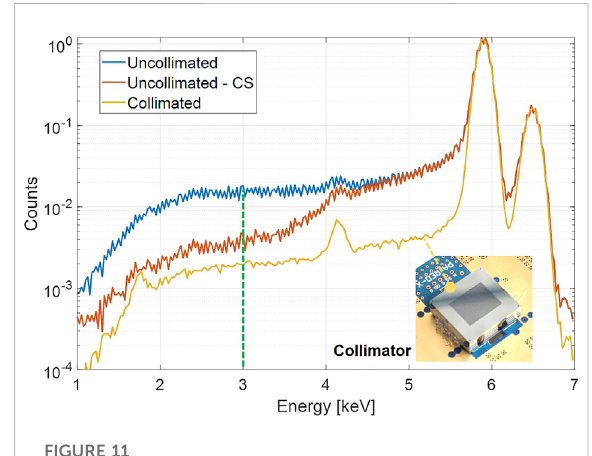
FIGURE 11 Impact of collimation, both physical and electronic, on acquired spectra (herenormalized): uncollimated spectrum(blue), spectrum with removal of charge-sharing (CS) events detected withtiminginformation(orange)andcollimated one(yellow). The background is computed around the energy of 3